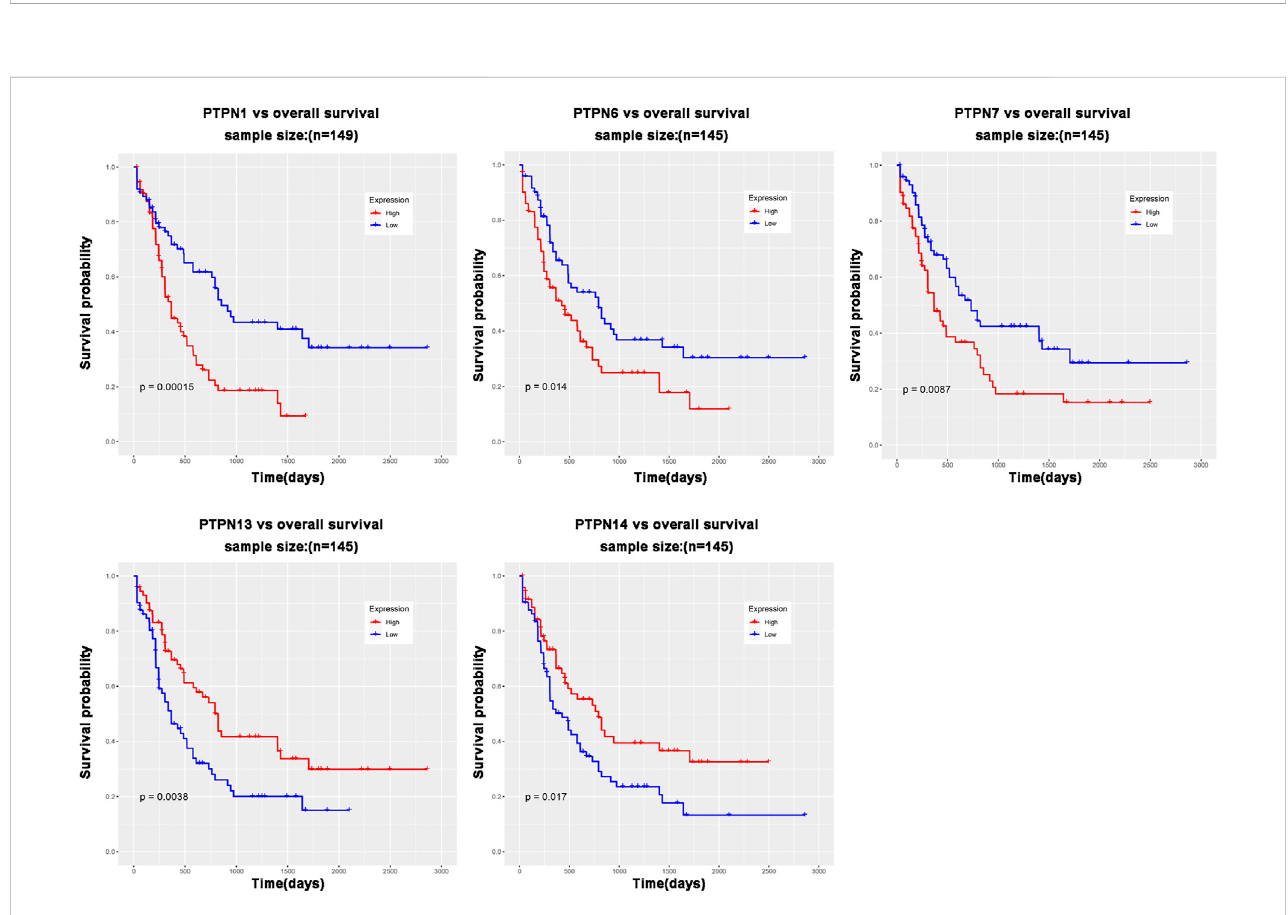
FIGURE 3 PTPN genes whose expression level is related to patient prognosis in AML